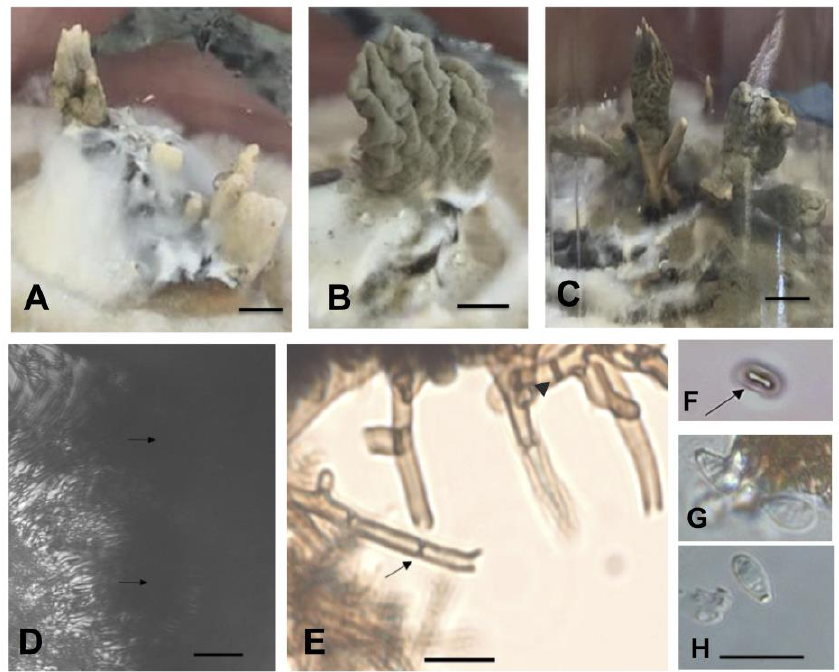
Figure 5. Isolated Xylaria sp. 1. (HBEI 021) ( A – C ). Stromata obtained in culture on MEA 2% medium; ( D – F ). Bright-field microscopy; ( D ). Initial formation perithecia (arrows); ( E ). Hyphae regularly septated (arrow) with branches forming 90° angles (arrowhead); ( F ). Ascospores with longitudinal germ slit (arrow); ( G , H ) Differential interference contrast microscopy (DIC), Conidiospore.—Scale bars ( A – C ) = 4 mm, ( D – H ) = 10 µm.